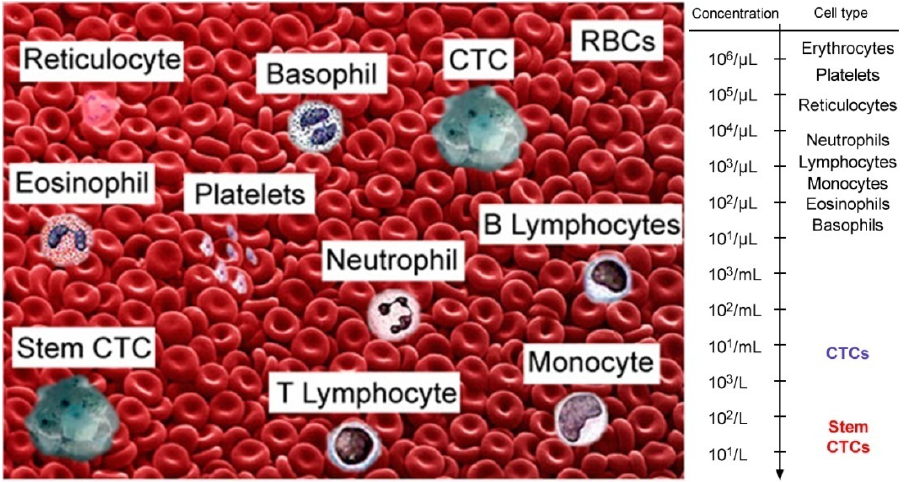
Figure 1. Typical blood composition and concentration levels of bulk and stem CTCs in blood